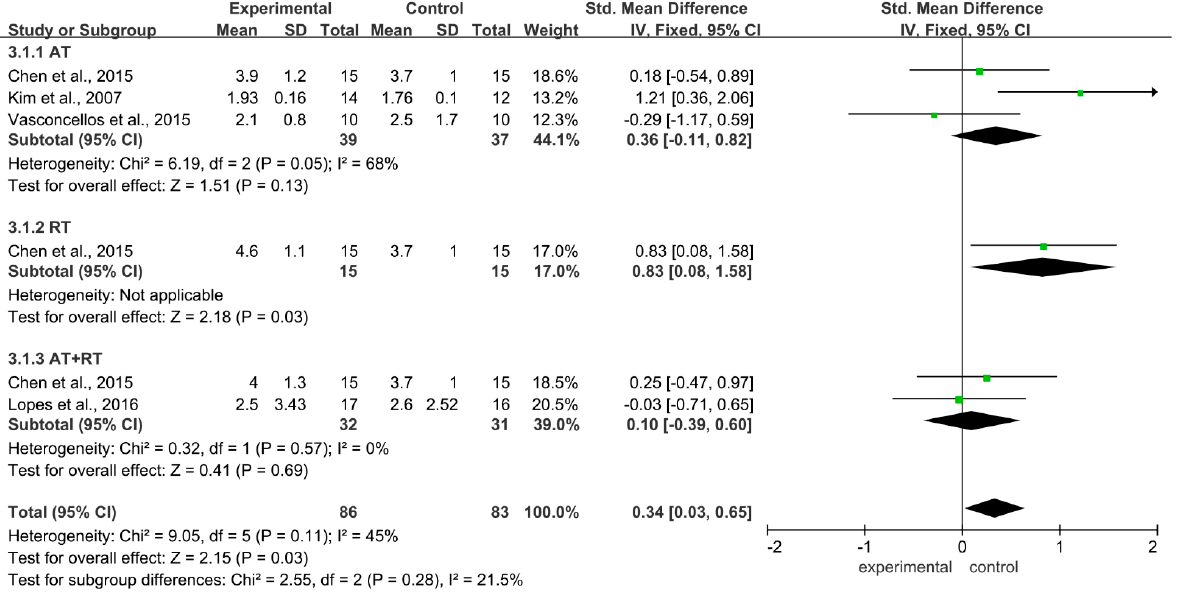
Figure 4. Meta-analysis of the effects of different training modalities on the level of TNF- α in adolescents with obesity.